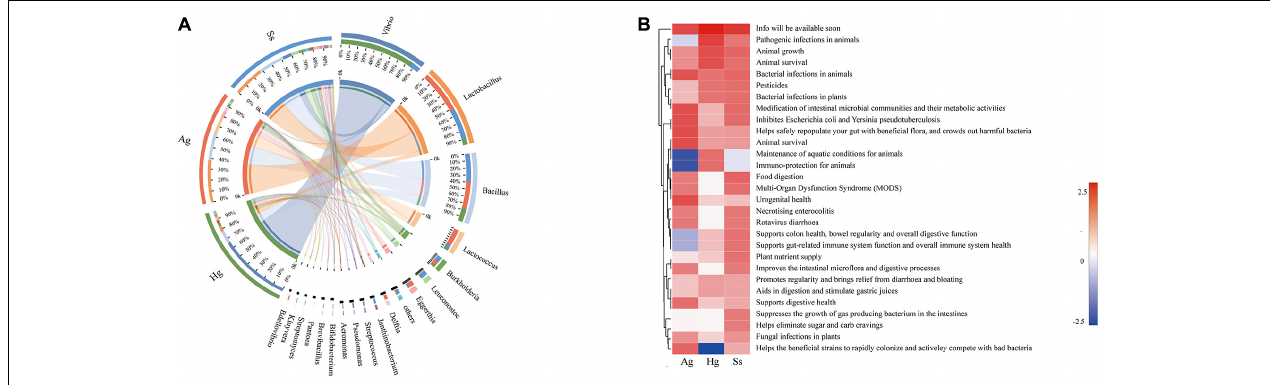
FIGURE 6 | Composition and functional analysis of probiotics in intestine samples of hadal amphipods. (A) Relative abundance of probiotics at genus level of intestinal metagenomic samples from three hadal amphipods, Hg, Ss, and Ag. (B) Functional composition of